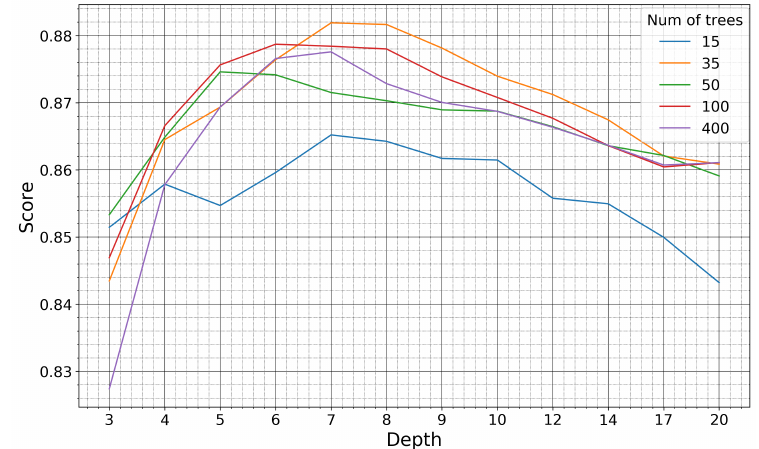
Figure 10. Kappa coefficient of the Haenam site for models trained on pseudo-labels of the Seosan- Dangjin site, with various depth sizes and number of trees.